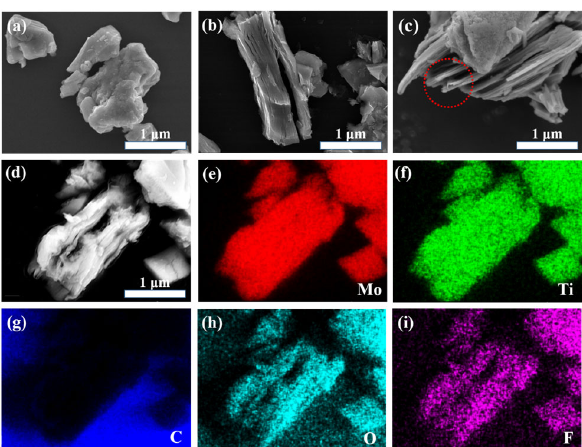
Fig. 2 SEM images of (a) Mo 2 TiAlC 2 , (b) m-Mo 2 TiC 2 T x , (c) T2, and (d) T3. (e–i) EDS mappings of MoO 3 /TiO 2 / Mo 2 TiC 2 T x MXene (T3) corresponding to